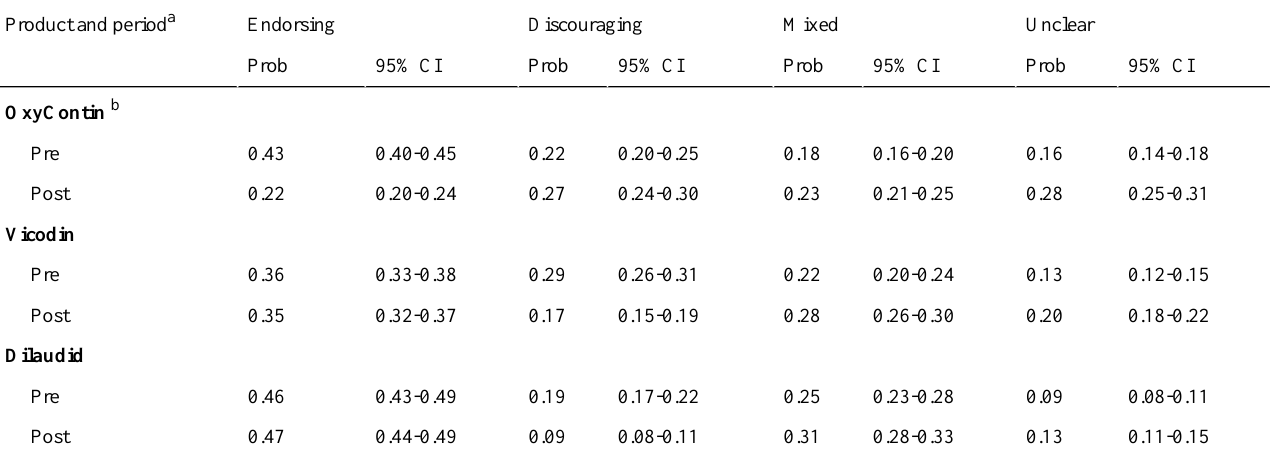
Table 2. Abuse-related sentiment category probabilities. UnclearMixedDiscouragingEndorsingProduct and period a